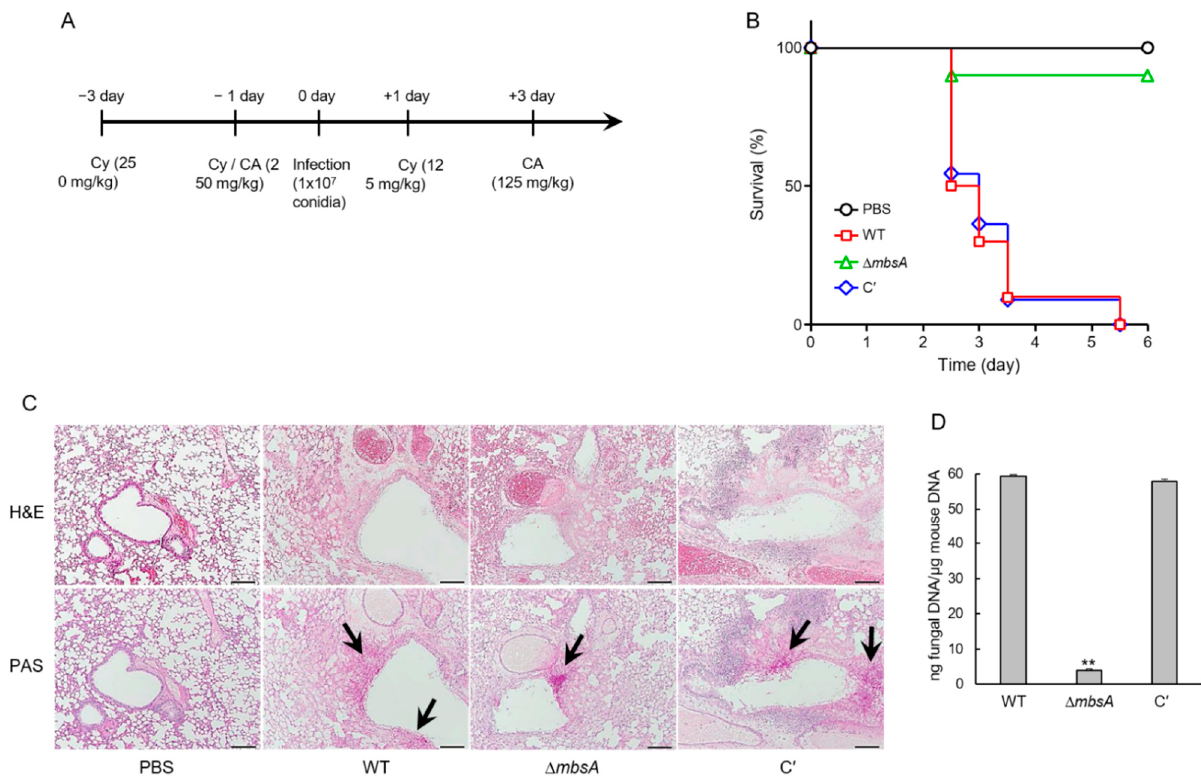
Figure 8. MbsA’s role in virulence. ( A ) Schematic presentation of A . fumigatus infection in immunocompromised mouse model. Six-week-old female ICR mice were immunocompromised by treatment of cyclophosphamide (Cy, 250 mg/kg at day − 3 and − 1 and 125 mg/kg at day +1) and cortisone acetate (CA, 250 mg/kg at day − 1 and 125 mg/kg at day +3). On day 0 mice were intranasally infected. ( B ) Survival curve of mice infected with WT, Δ mbsA , and C ′ strains ( n = 10/group). ( C ) Lung sections after each strains infection were stained with Hematoxylin and Eosin (H&E) or Periodic-acid Schiff (PAS). Arrows indicate fungal mycelium. Bars indicate 200 µm. ( D ) Fungal burden in the lungs of mice infected with WT and Δ mbsA , and C ′ strains. Data are represented as mean ± standard deviation from three independent experiments. ANOVA test: ** p < 0.01.